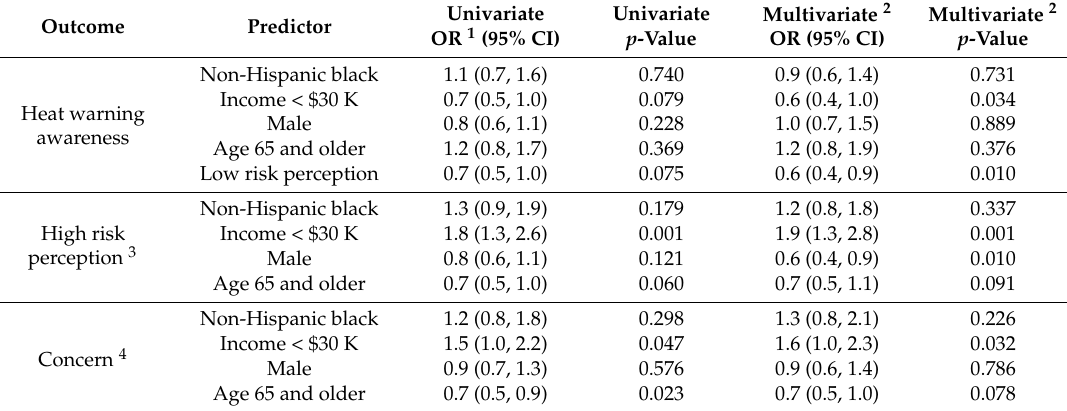
Univariate Univariate Multivariate 2 Multivariate 2 p -Value OR 1 (95% CI) p -Value OR (95% CI)